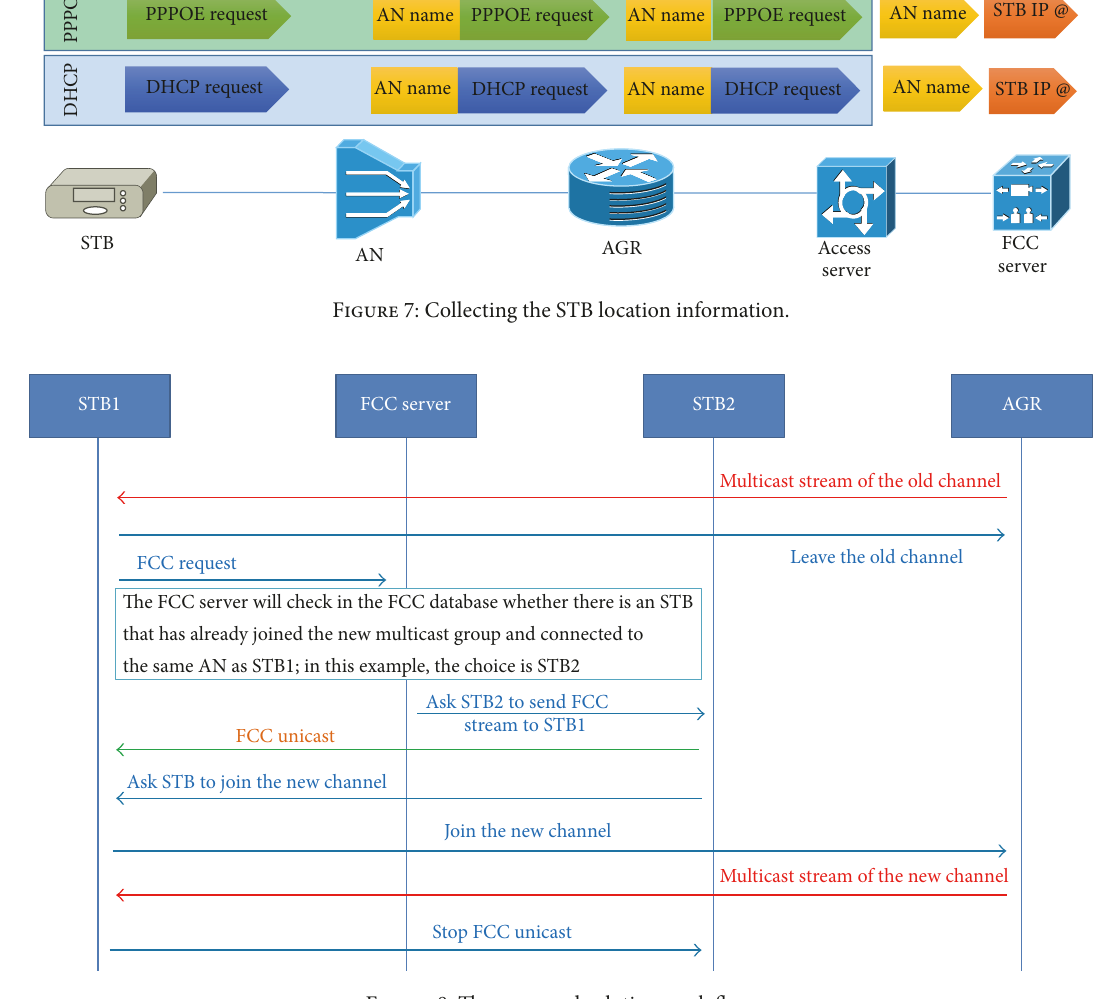
Figure 8: The proposed solution work